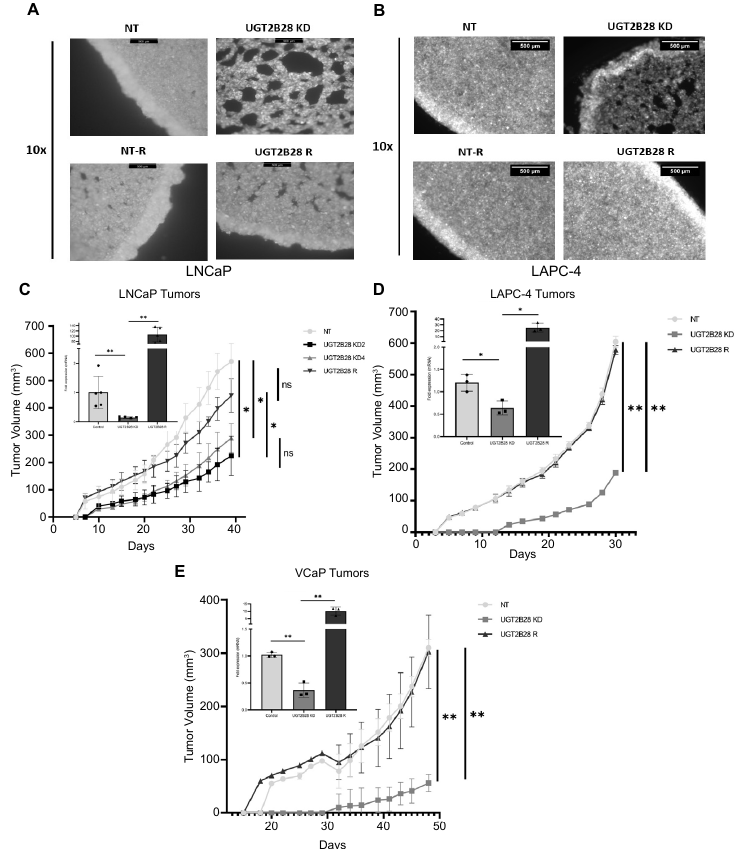
Figure 3. UGT2B28 deficiency in PCa cells impairs organoid formation in vitro and prolongs tumor take and growth in vivo. ( A ). 10× magnified Green Fluorescence Protein (GFP) images of 3D organoids formed from stably transduced LNCaP cells containing control (NT), UGT2B28 KD, UGT2B28 re-expression (Control + OE), and UGT2B28 re-expression rescue (UGT2B28 R) in the KD setting (UGT2B28 rescue). The 3D organoid formation was conducted in triplicates/group/cell line in Millicell inserts for 24 h. Scale bar = 500 µ m. ( B ). Same as in ( A ), but for LAPC-4 cells. ( C ). Tumor growth curve of xenografts generated using LNCaP cells containing NT, UGT2B28 KD, and UGT2B28 R in athymic nude mice supplemented with testosterone. ( D ). Same as in ( C ), but for LAPC-4. ( E ). Same as in ( C ), but for VCaP. For panels ( C – E ), please refer to legends for number of replicates in each group. Inset shows verification of UGT2B28 transcript expression in xenograft tumors obtained from each group. The data are represented as the mean + / − the standard deviation (SD). * p < 0.01, ** p < 0.001, ns: not